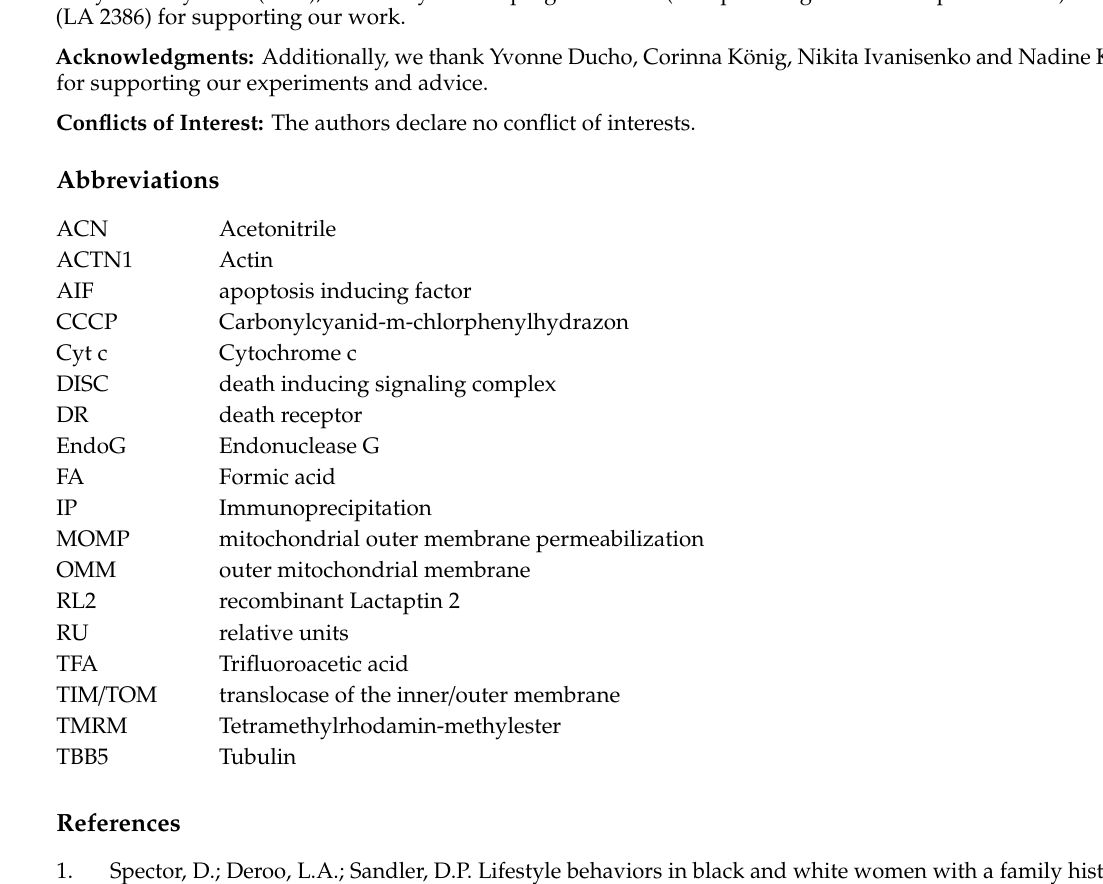
RL2-interacting proteins in Figure 4B, are based on the absolute values shown here. The abbreviations n1, n2 and n3 indicate absolute values for every experimental replicate, Table S2: Absolute values of unique peptides and coverages of all mitochondrial proteins identified by mass spectrometry. Abbreviations n1, n2 and n3 indicate absolute values for every experimental